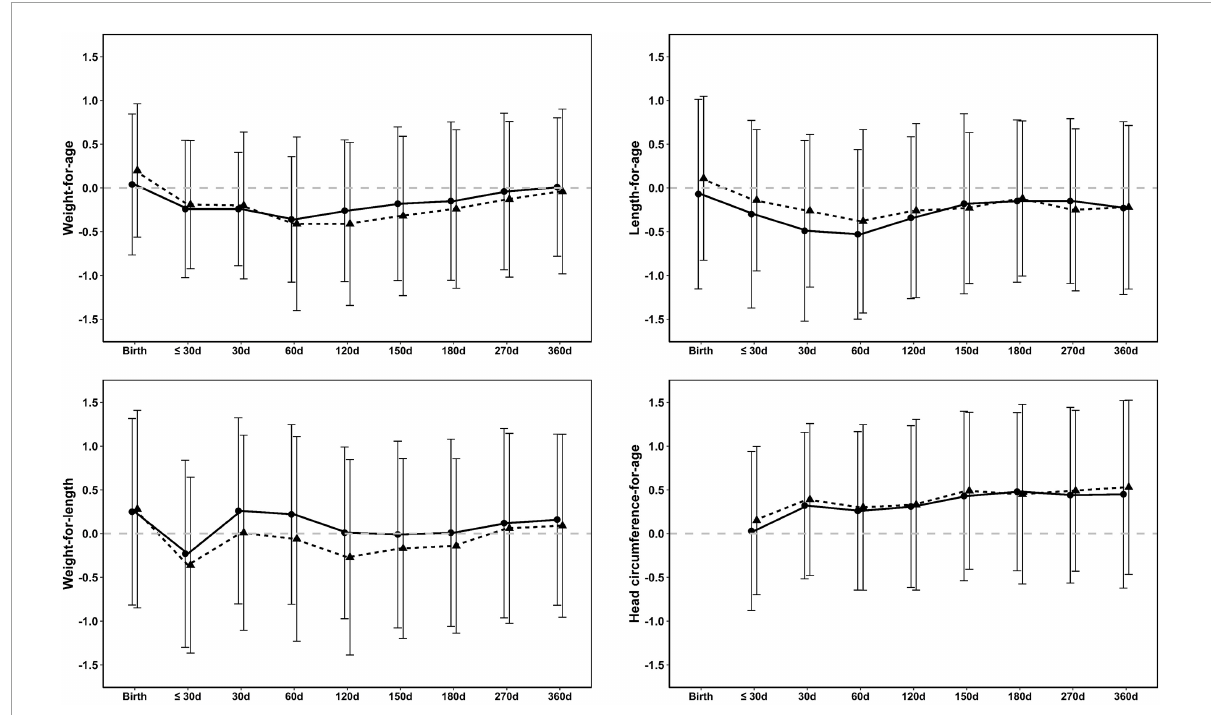
FIGURE2 Mean ± SD weight-for-age, weight-for-length, length-for-age, and head circumference-for age z -scores from birth to 12 months (360 days) in formula-fed (circles, solid line) and breastfed infants (triangles, dashed line) in the FAS population. The dashed gray line represents the WHO median (36).